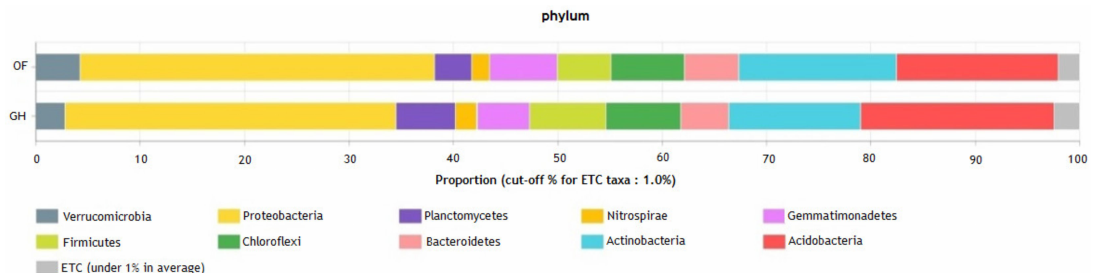
Figure 3. Relative abundance of the dominant bacterial phyla in soil on June as affected by open-field (OF) and greenhouse (GH) cultivated red